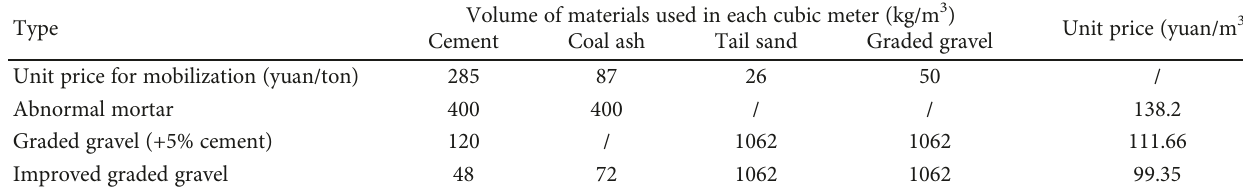
Table 3: Correlation Table for Unit Prices of Graded Gravel Transformed before and after